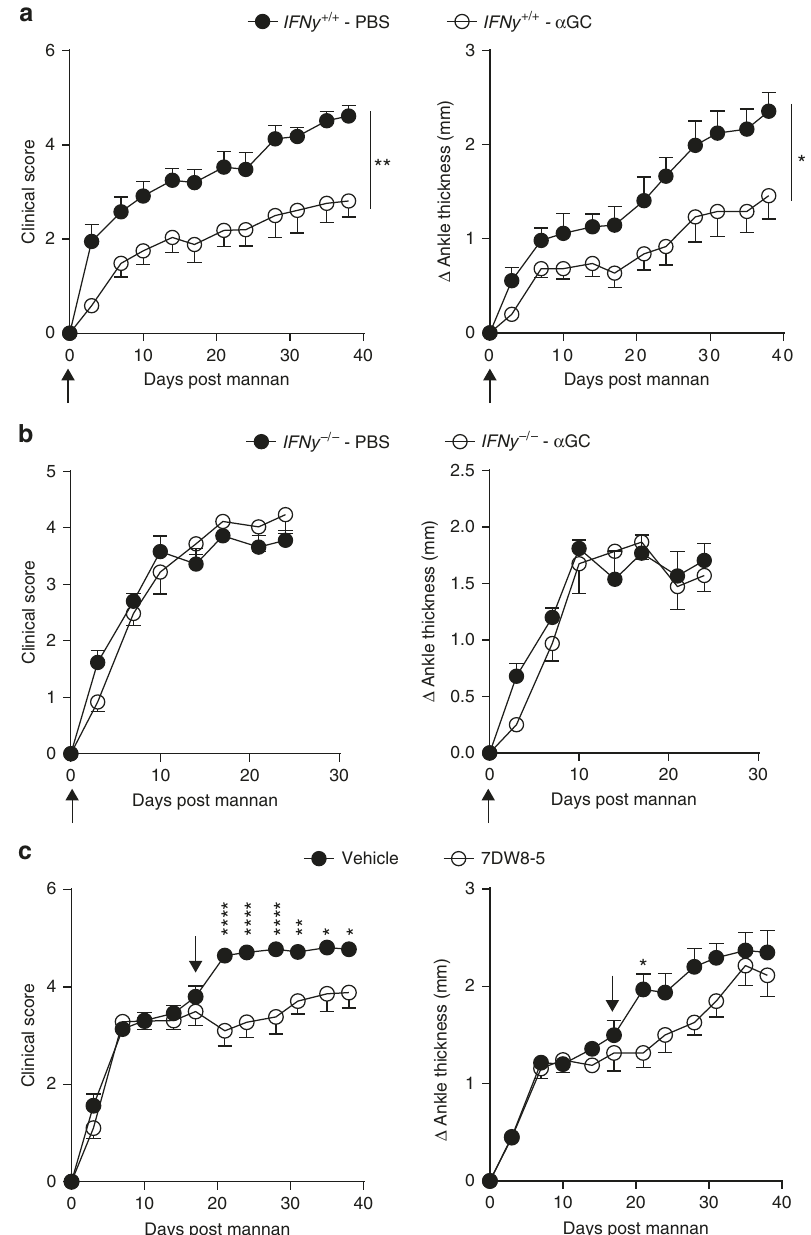
Fig. 7 NKT1-biased activation suppresses progression of arthritis in SKG mice. a Clinical score (left panel) and change in ankle thickness (right panel) in WT ( Ifng + / + ) SKG mice with mannan-induced arthritis after treatment with either PBS (r.o, n = 6) or α GC (4 μ g, r.o., n = 8) at the day of arthritis induction (indicated by arrow). ( b ) Clinical score (left panel) and change in ankle thickness (right panel) in IFN- γ -KO ( Ifng − / − ) SKG mice with mannan-induced arthritis after treatment with either PBS (r.o., n = 5) or α GC (4 μ g, r.o., n = 6). α GC was injected as above. c Clinical score (left panel) and change in ankle thickness (right panel) in SKG mice with mannan-induced arthritis treated with either vehicle control (i.p. n = 8) or 7DW8-5 (4 μ g, i.p., n = 8) 17 days after mannan injection (indicated by arrow). Compiled data from at least three independent experiments are shown. Graphs represents mean ± SEM. * p < 0.05, ** p < 0.01 *** p < 0.001, **** p < 0.0001. (Mann – Whitney on the area under curve ( a , b ), Two-way ANOVA ( c